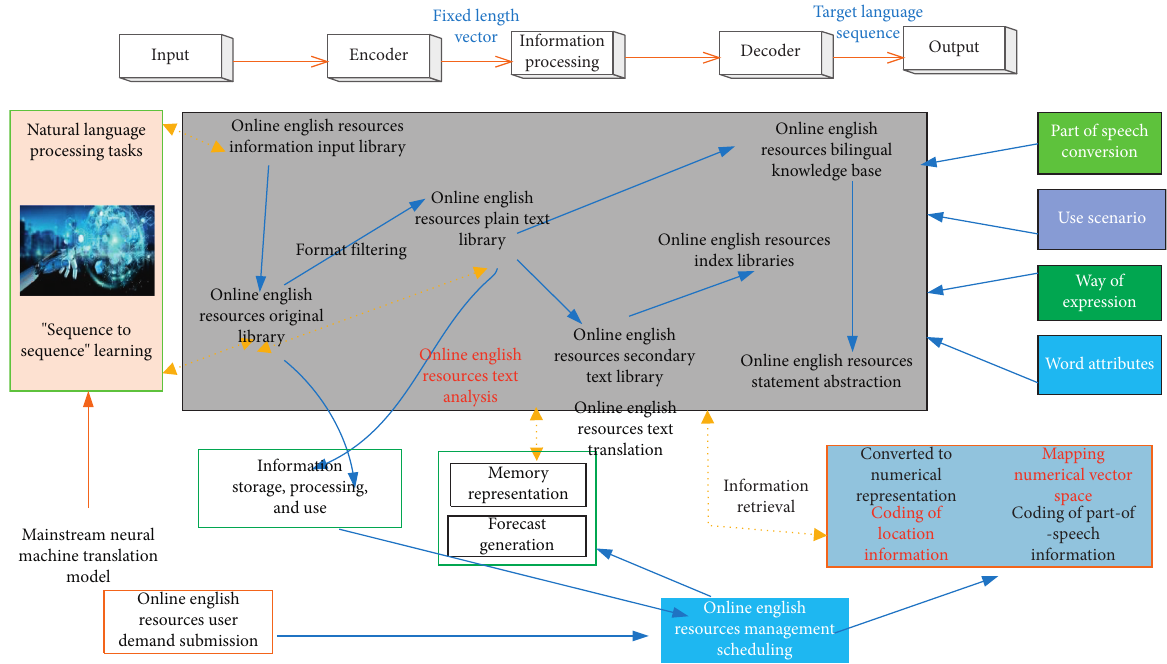
Figure 1: Schematic diagram of online English resource information processing for neural machine translation.